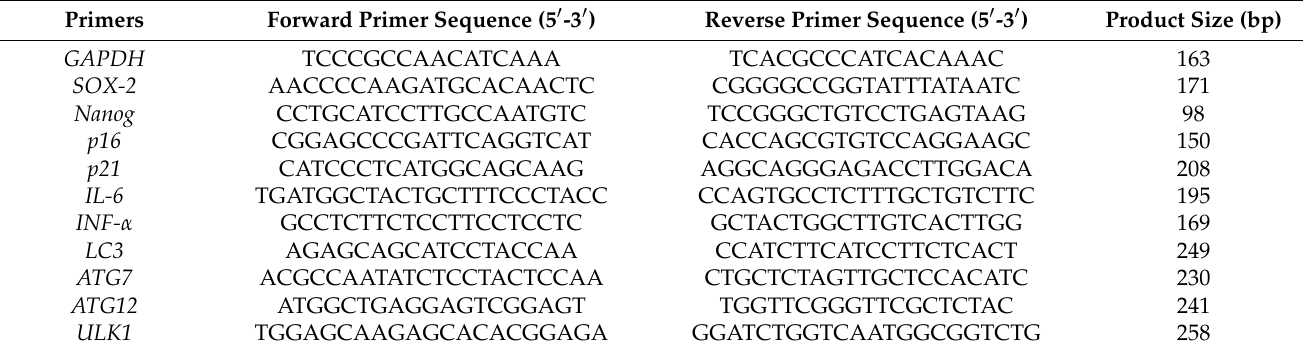
Table 2. Primers used for real-time quantitative